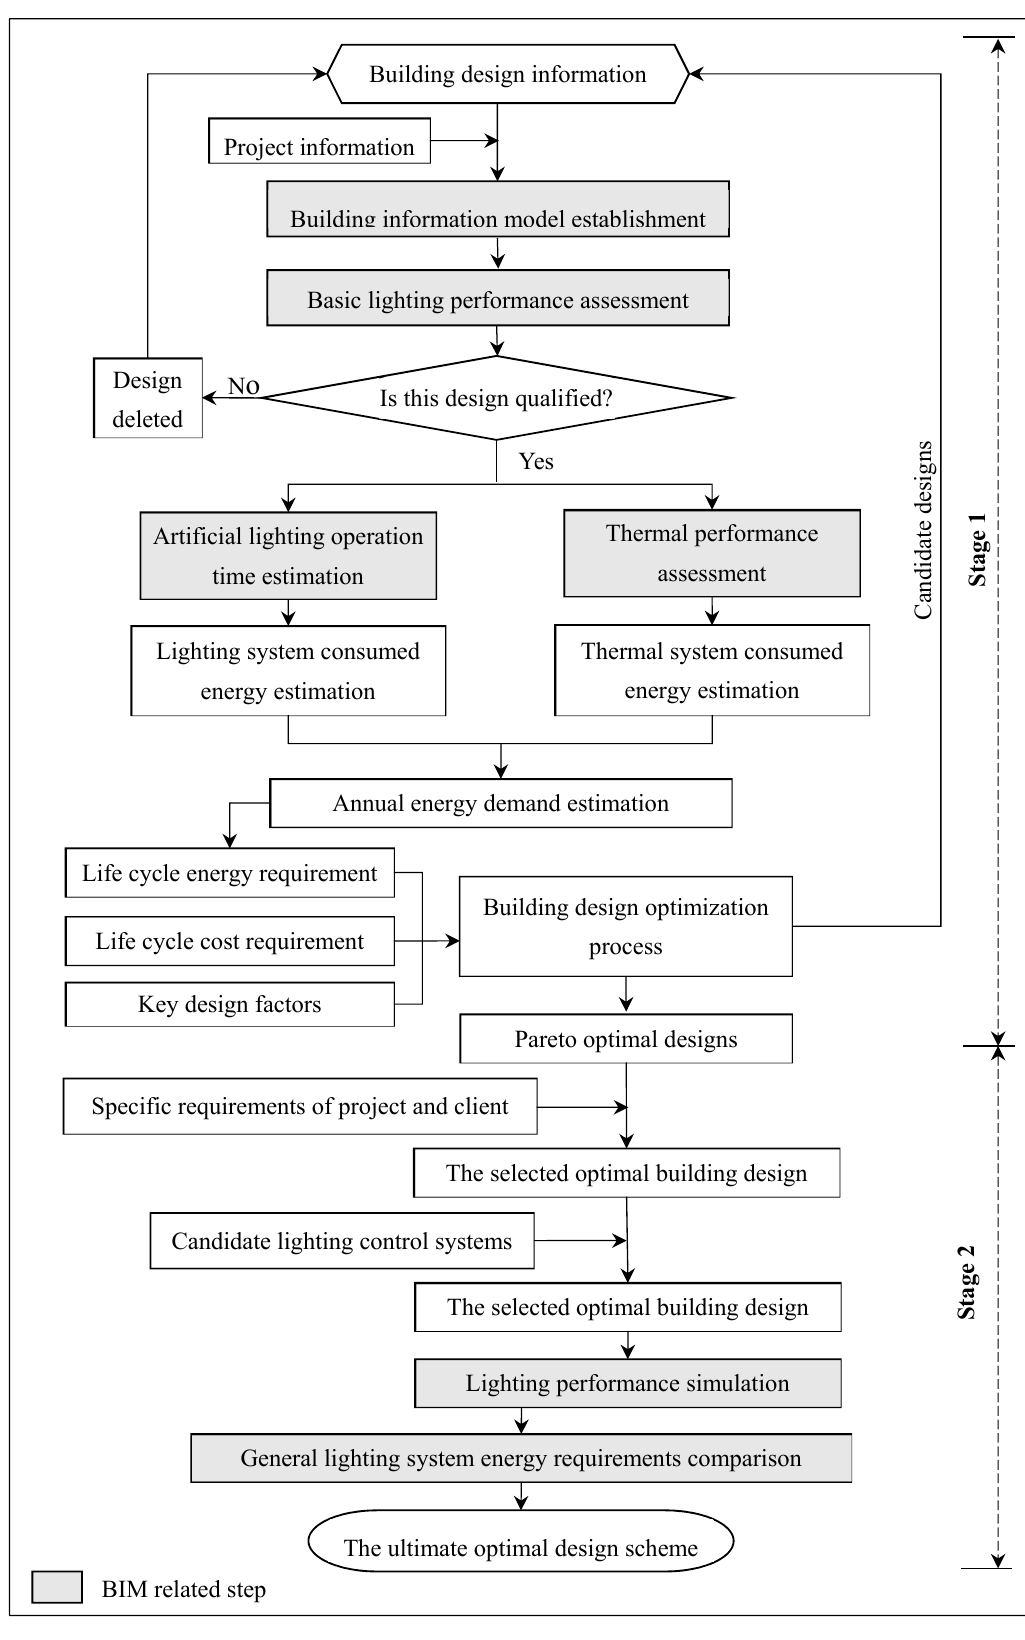
Figure 1. Schematic structure of the proposed building information modelling (BIM) based building design method.